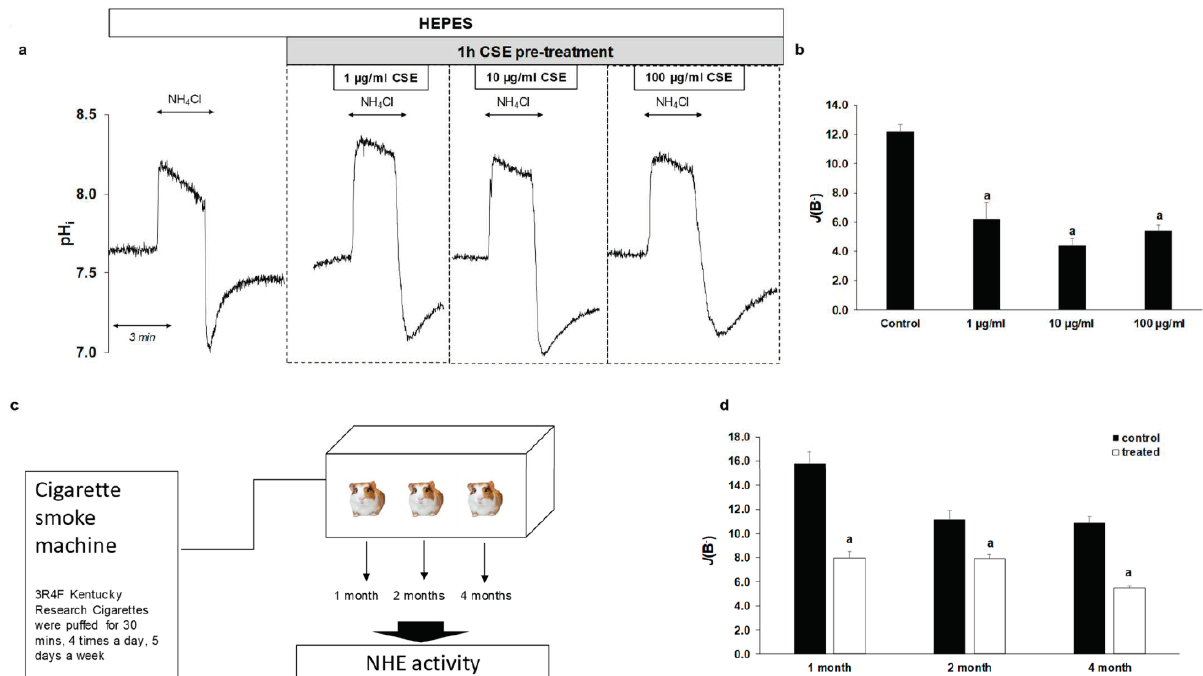
Figure 5. Effects of cigarette smoke extract (CSE) treatment and smoking on the activity of Na + /H + exchanger-1 (NHE-1) in guinea pig esophageal epithelial cells (EECs). ( a ) Normal guinea pig EECs were pretreated with different concentrations of CSE (1, 10 and 100 µg/mL) for 1 h and the activity of NHE-1 was measured. Representative intracellular pH (pH i ) curves show the recovery from acidosis. ( b ) Summary data of the calculated activity of NHE-1 in guinea pig EECs. The rate of pH recovery ( J (B − )) was calculated as described in Figure 2b. Data are presented as the mean ± SEM; a: p ≤ 0.05 vs. control; n = 13–18 exp./86–99 ROIs. ( c ) Chronic effect of cigarette smoking was investigated, using smoking chamber. Guinea pigs were exposed to whole body cigarette smoke 4 times a day, 5 days a week, 30 min each time, using a TE2 closed-chamber manual smoking system. After 1, 2, or 4 months of smoking, the animals were sacrificed and NHE-1 activity was measured. ( d ) Summary data of the calculated activity of NHE-1 in guinea pig EECs. The rate of pH recovery ( J (B − )) was calculated as described in Figure 2b. Data are presented as the mean ± SEM; a: p ≤ 0.05 vs. control; n = 8–16exp./81–210 ROIs.